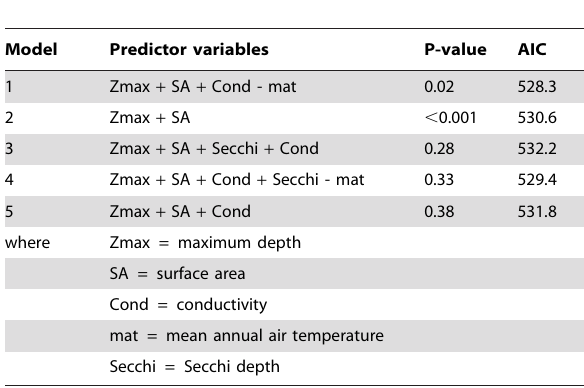
Table 2. Logistic regression models predicting